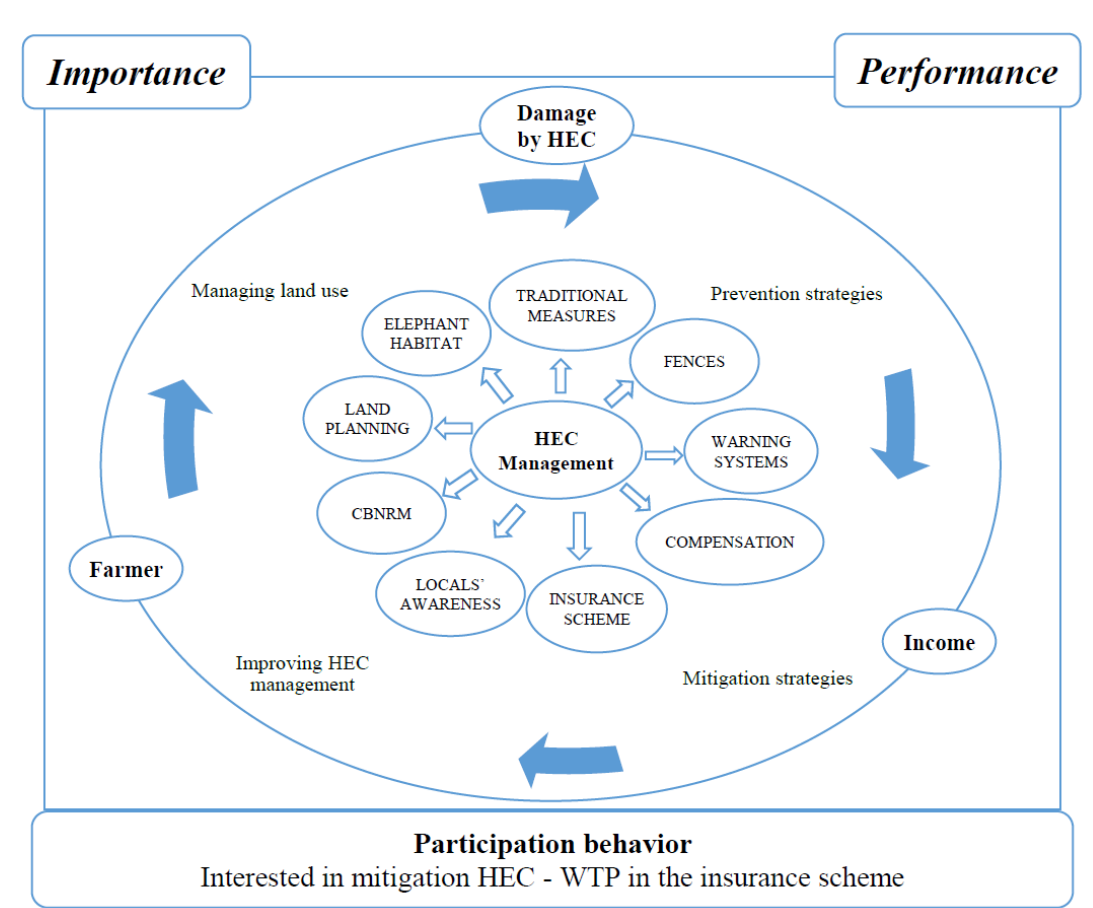
Figure 4. The evaluation framework of IPA for HEC management.